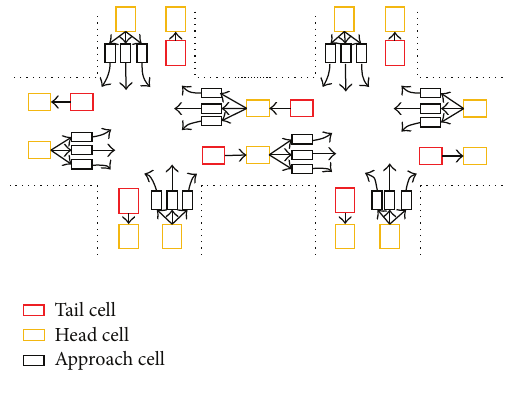
Figure 1: Enhanced